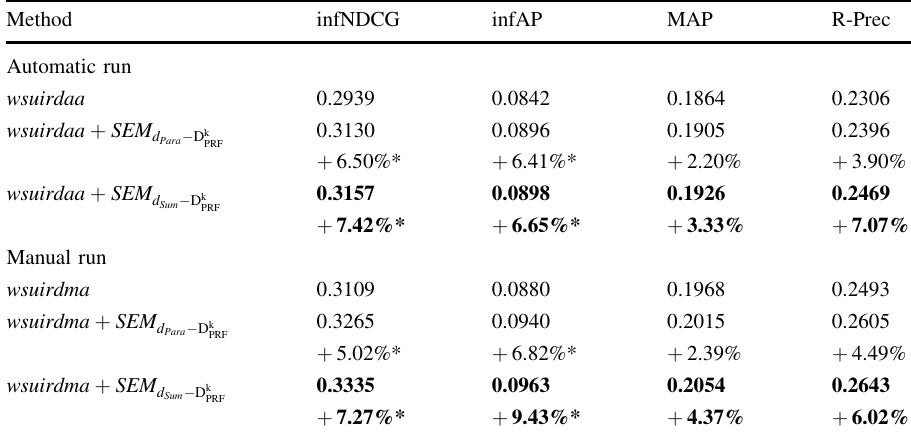
Table 8 The evaluation